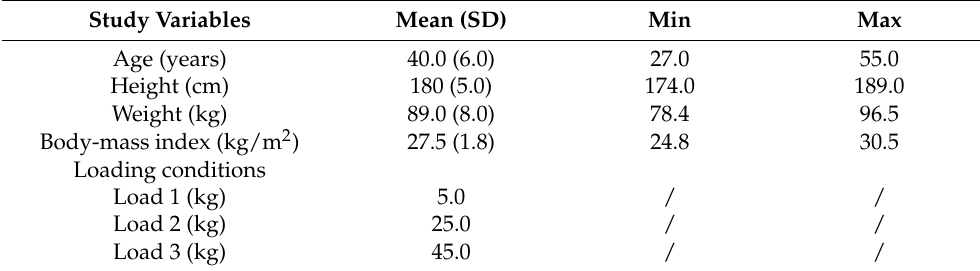
Table 1. Basic descriptive statistics of the study participants (N =